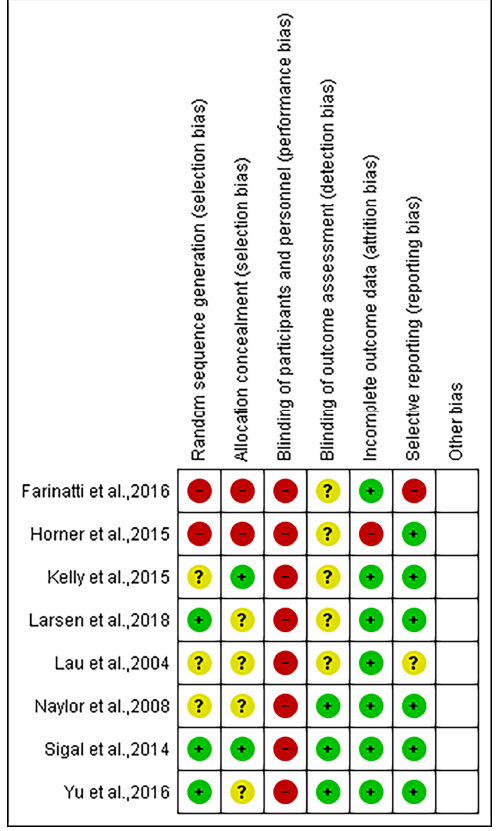
Figure 2. Summary of the risk of bias for the trials included in this meta-analysis. Green indicates low risk of bias, yellow indicated unclear, and red indicates high risk of bias.